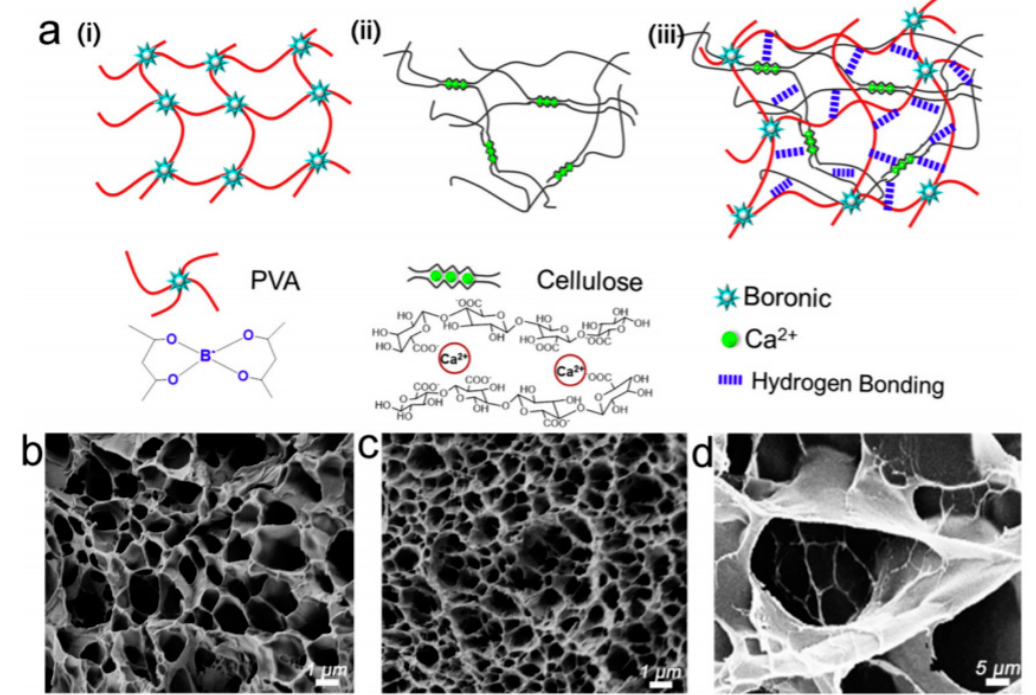
Figure 17. ( a ) Structure of the self-healing hydrogel: ( i ) PVA hydrogel, ( ii ) cellulose nanofiber (CNF) network, and ( iii ) PVA/CNF hydrogel bend. ( b ) Morphologies of freeze-dried PVA hydrogel. ( c ) and ( d ) Morphologies of the freeze-dried PVA/CNF hydrogel. Reproduced from [76] with permission. Copyright 2019, Elsevier.